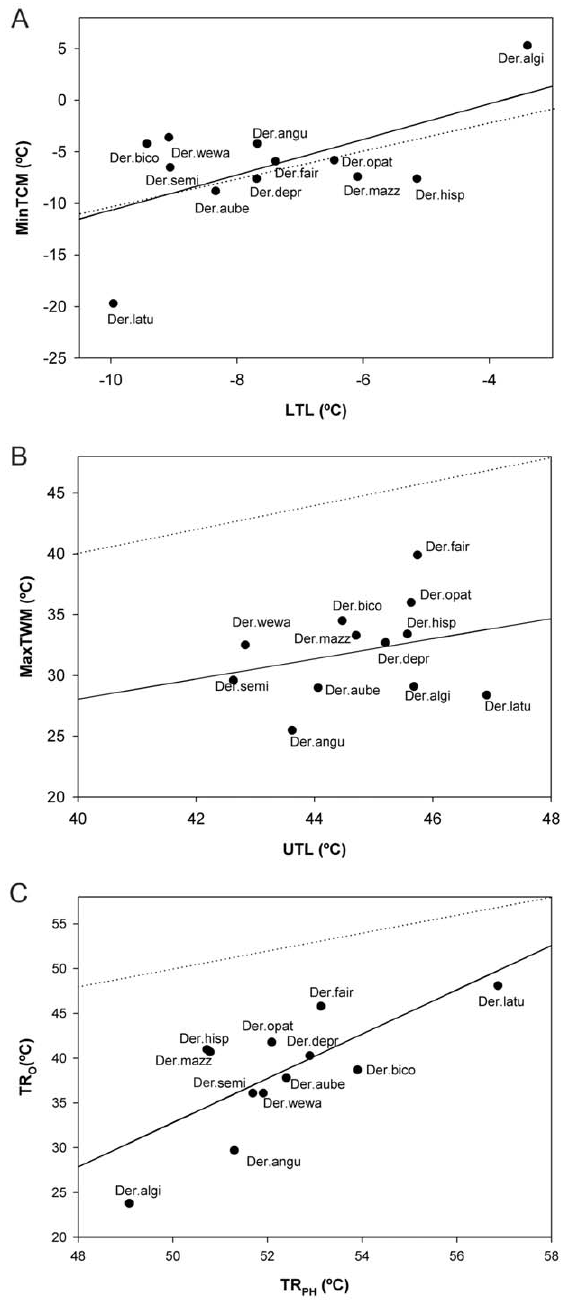
Figure 1. Tolerance to cold, heat and thermal range. Relation- ships between the tolerance to cold (A), heat (B) and thermal range (C), obtained from environmental data based on site occupancy (vertical axis) and from physiological experiments (horizontal axis). A) Highest value of the Maximum temperature of the warmest month (MaxTWM) from occurrence data, Upper Thermal Limit (UTL) from physiological experiments; B) lowest value of the minimum temperature of the coldest month (MinTCM) from occurrence data, Lower Thermal Limit (LTL) from physiological experiments; and C) thermal range (TR O ) from occurrence data and thermal range (TR PH ) from physiological experi- ments. Continuous line represents the regression line; dotted line is equality. Species names are